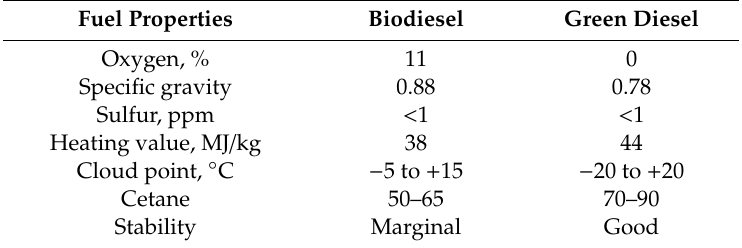
Table 1. Comparison of fuel quality: biodiesel vs. green diesel